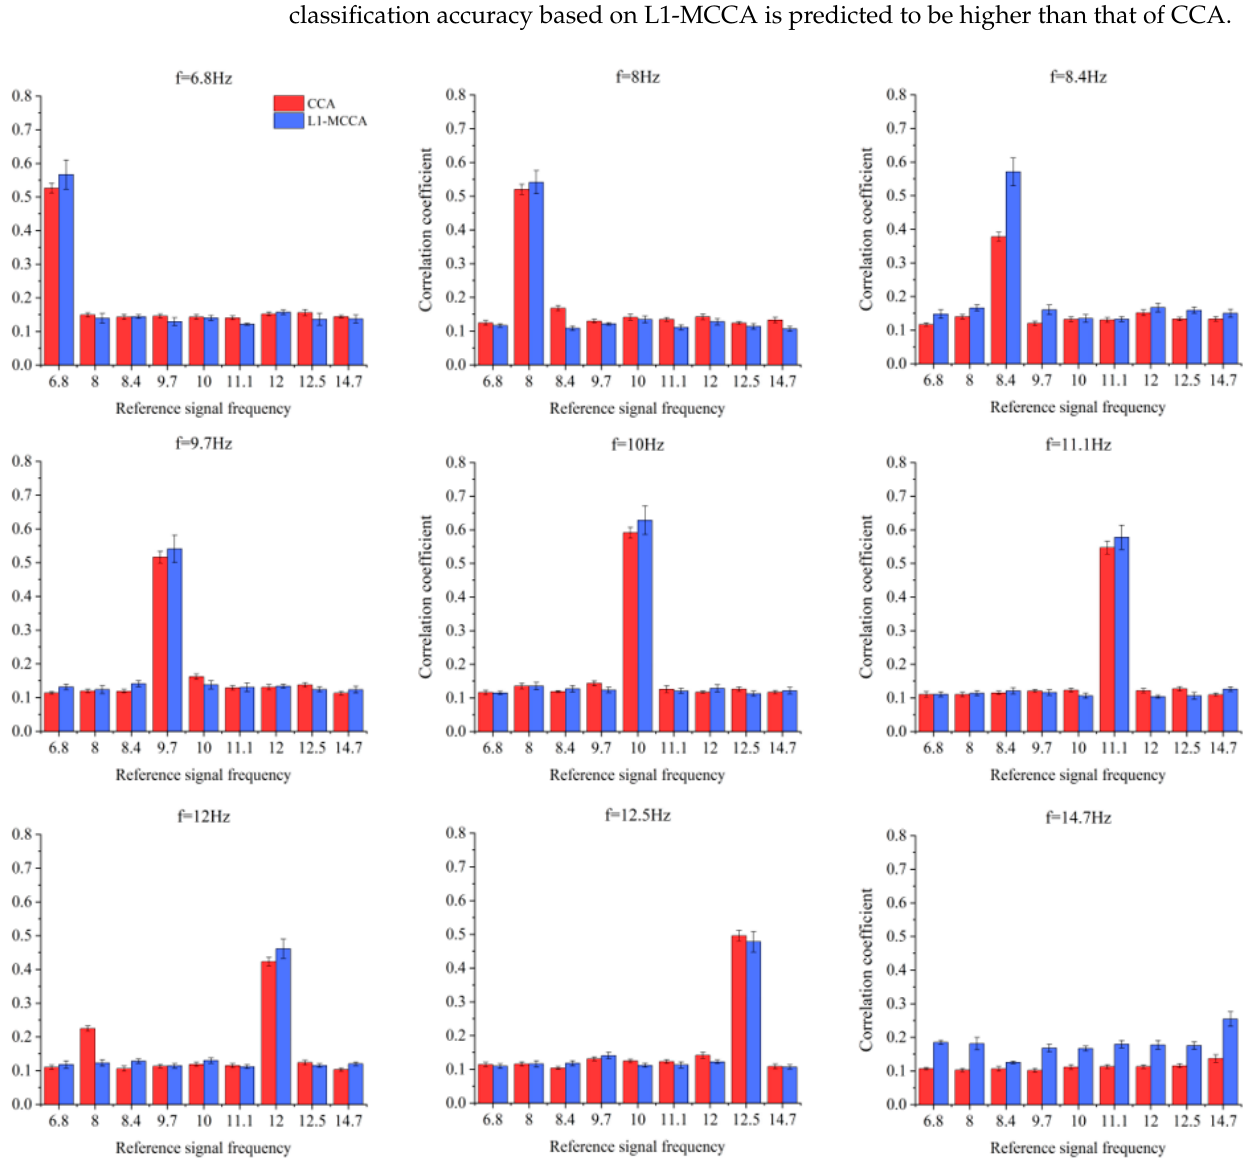
Figure 3. The SSVEP recognition accuracy rates of the 12 subjects derived by the CCA and L1-MCCA, respectively, with different time window (TW) from 1 to 6 s.